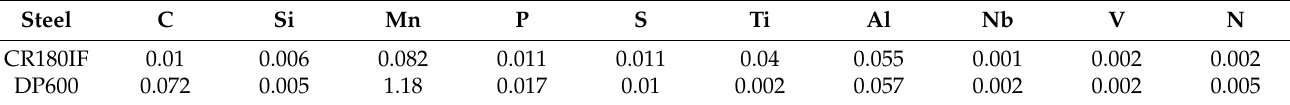
Table 1. Chemical compositions of investigated steels (wt